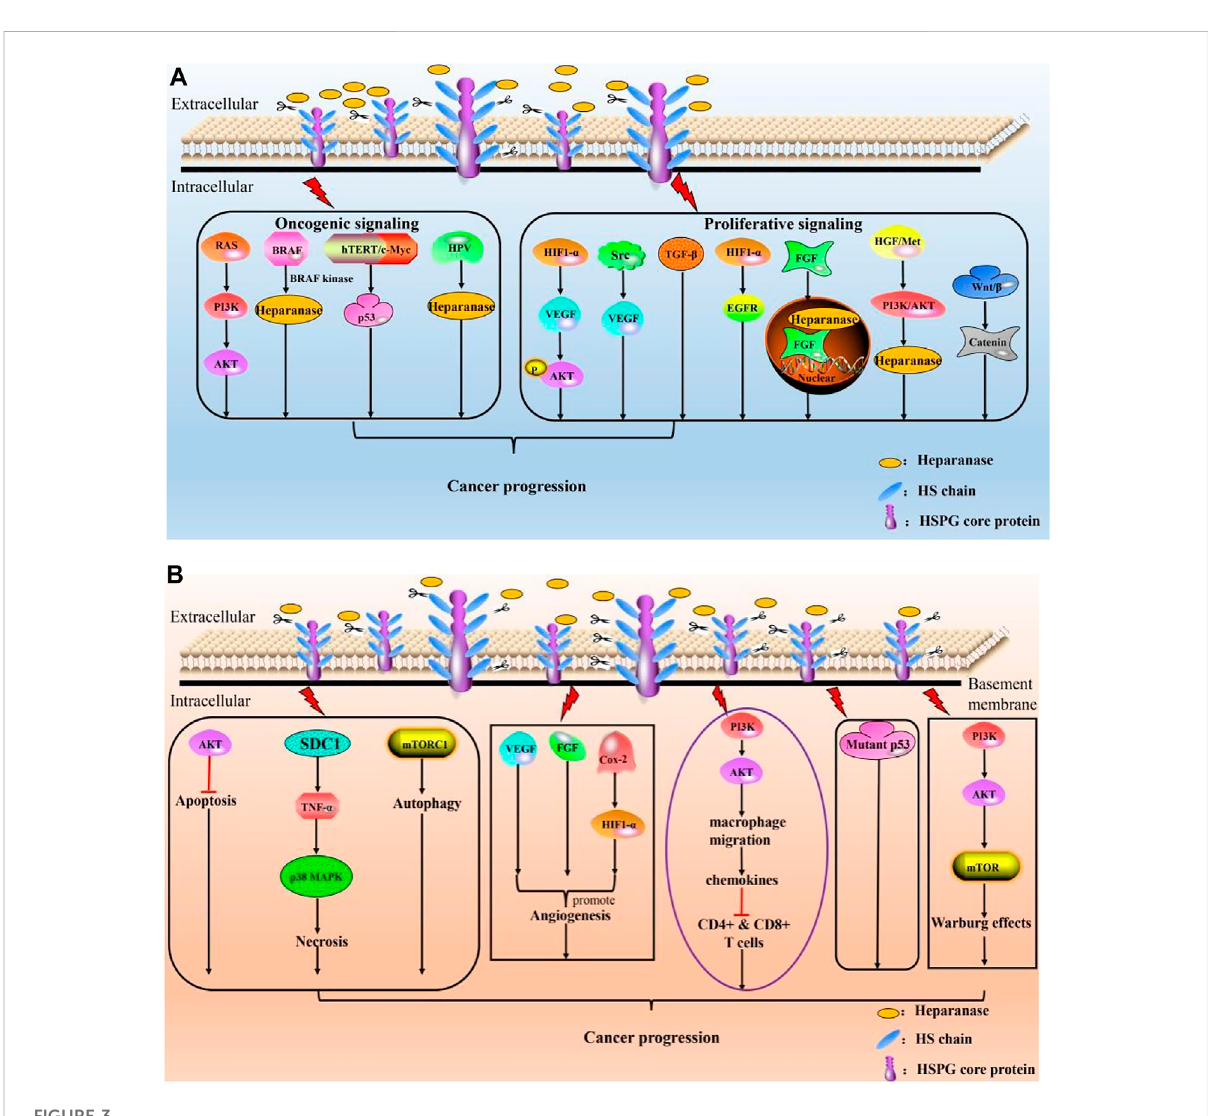
FIGURE 3 Roles of HPSE in cancer progression. (A) HPSE modulates cancer progression by mediating oncogenic signaling and proliferative signaling; (B) HPSE promotes cancer by resisting cell death, initiating angiogenesis, contributing to anti-immunity failure, circumventing growth inhibition and reprogramming energy